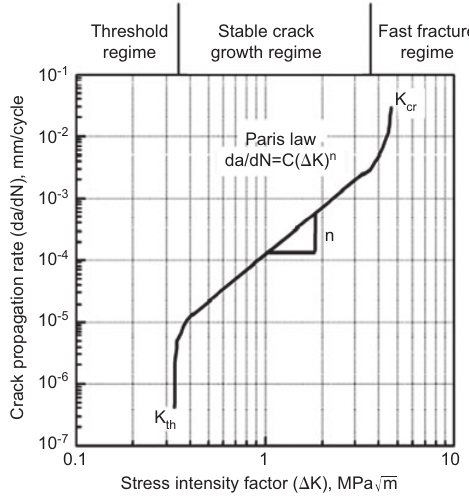
Figure 1 Schematic diagram of the fatigue propagation behaviour of